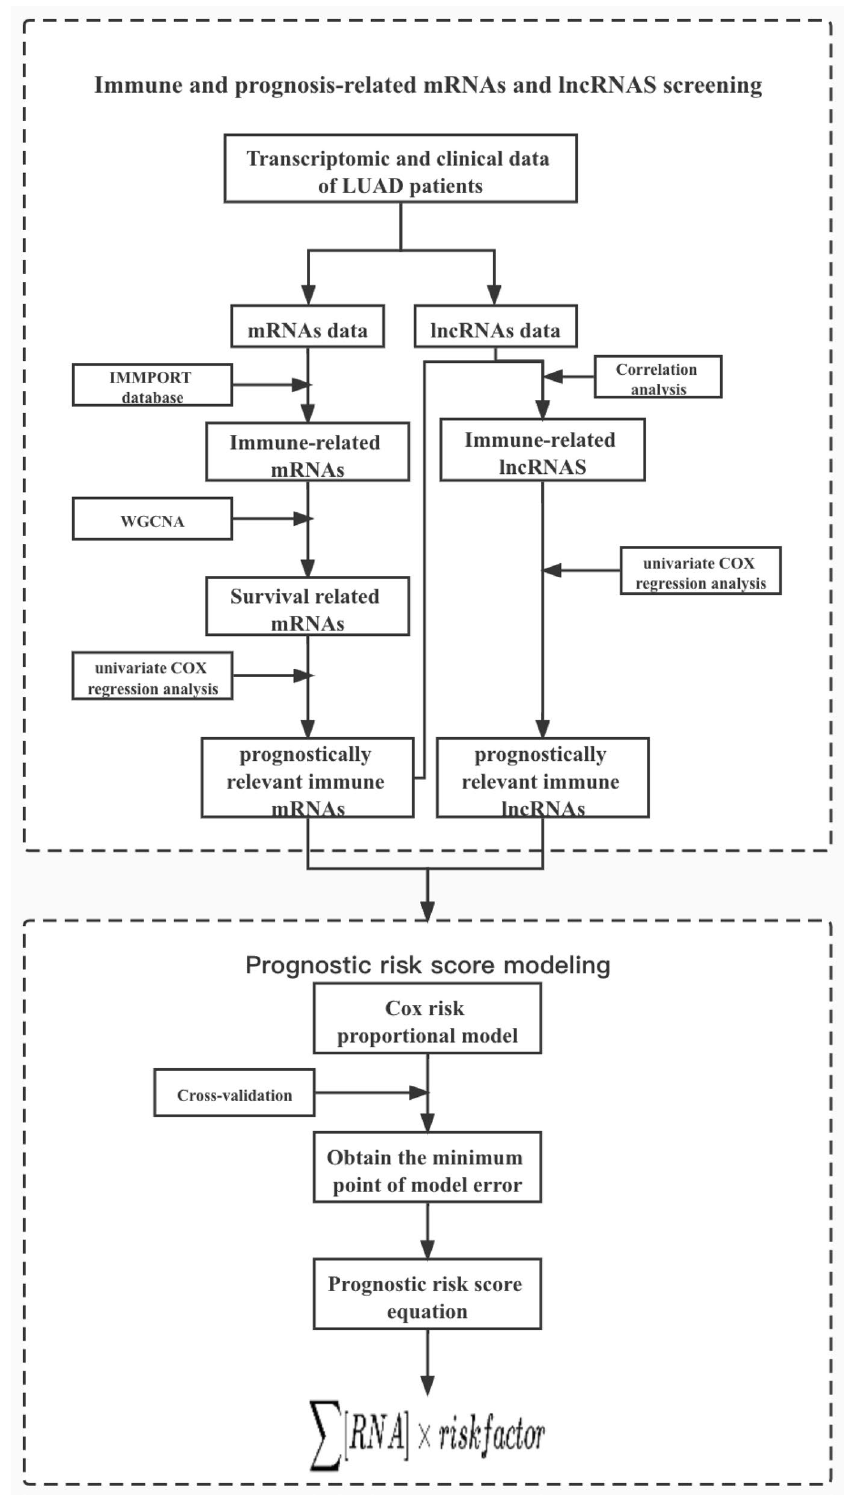
Figure 7. Workflow of immune and prognosis-related mRNAs and lncRNAs screening and prognostic risk scoring model construction. The lung adenocarcinoma data in TCGA database were divided into mRNA sub- dataset and lncRNA sub-dataset, and the mRNAs and lncRNAs associated with immunity and prognosis of lung adenocarcinoma were extracted by various methods such as WGCNA and COX regression, and the lung adenocarcinoma prognostic risk model was further constructed based on these associated